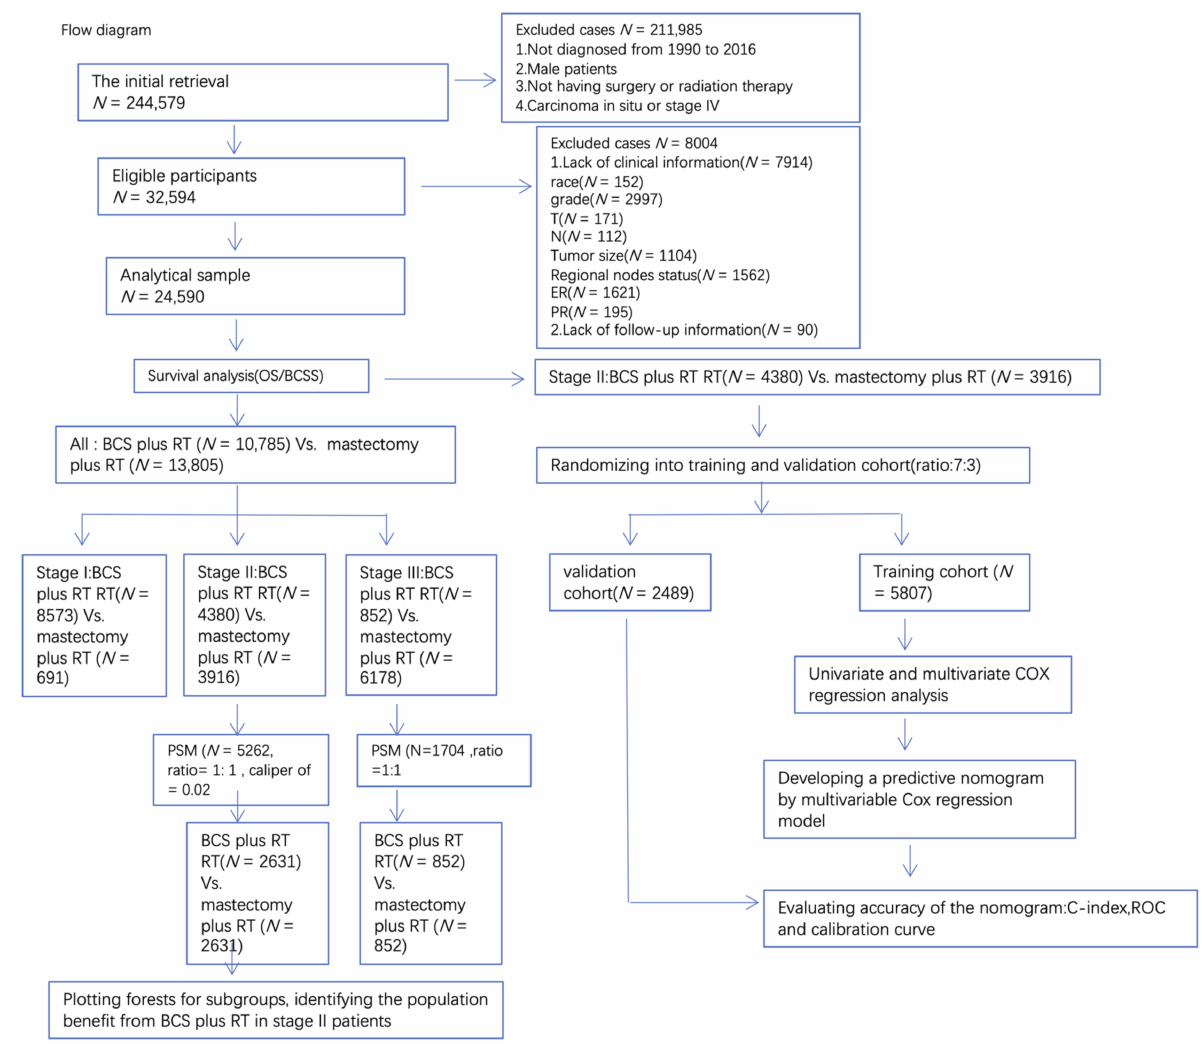
Figure 1. Flow diagram of selecting eligible